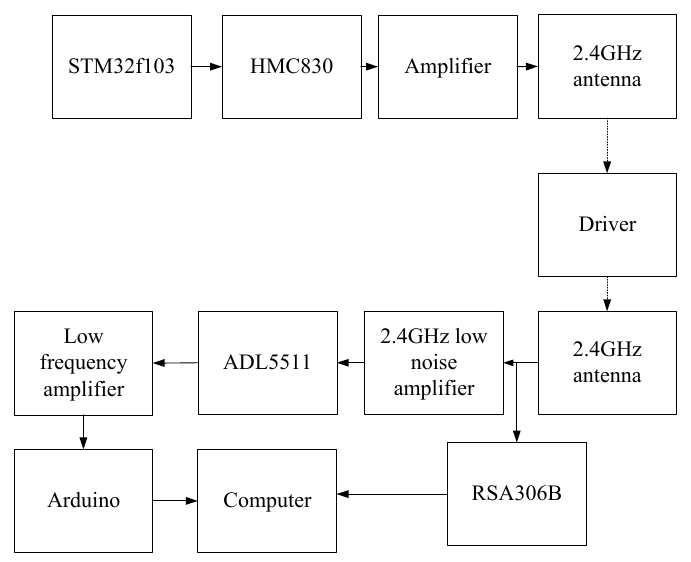
Figure 4. Experiment setup in car.